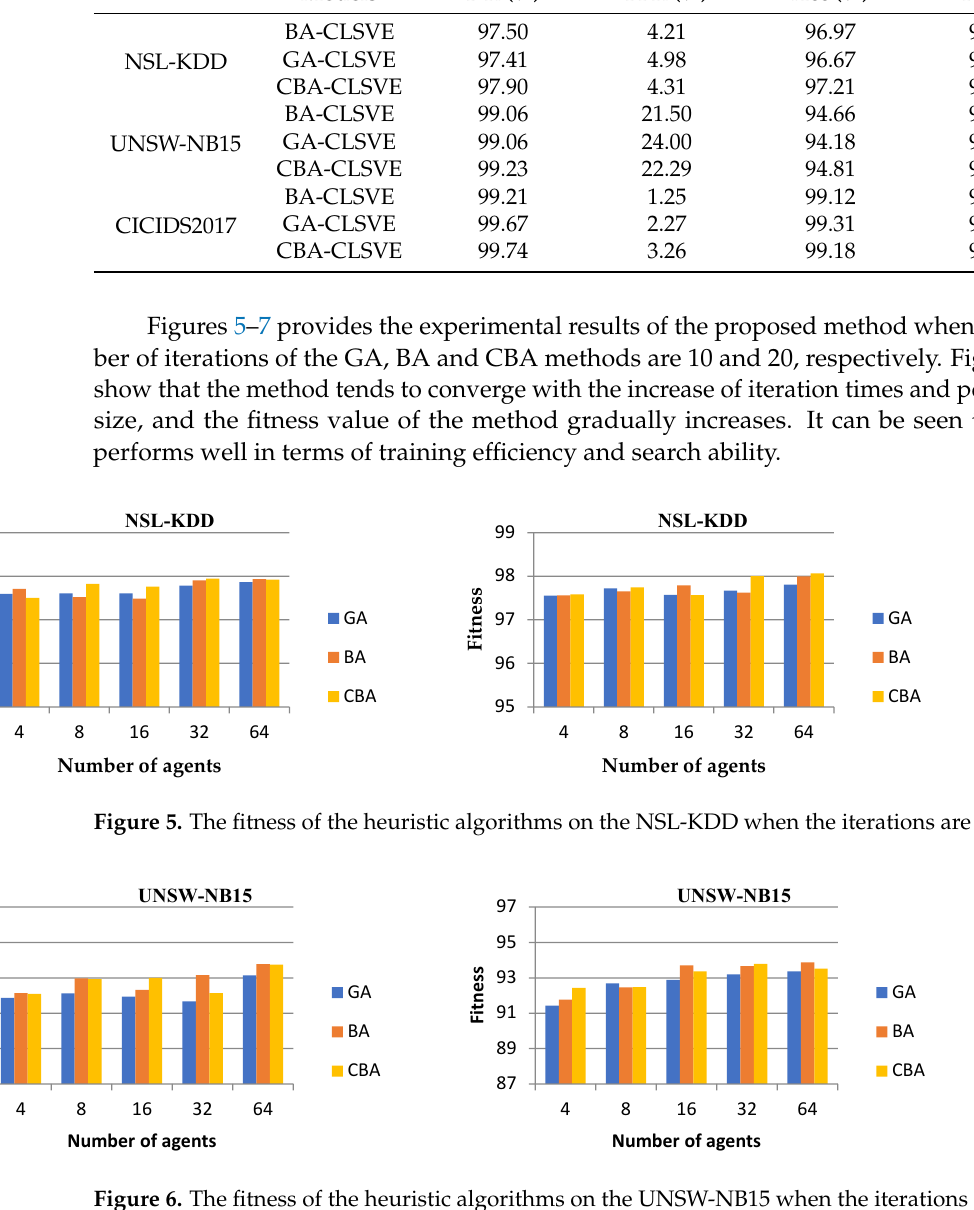
Figure 6. The fitness of the heuristic algorithms on the UNSW-NB15 when the iterations are 10 and 20.